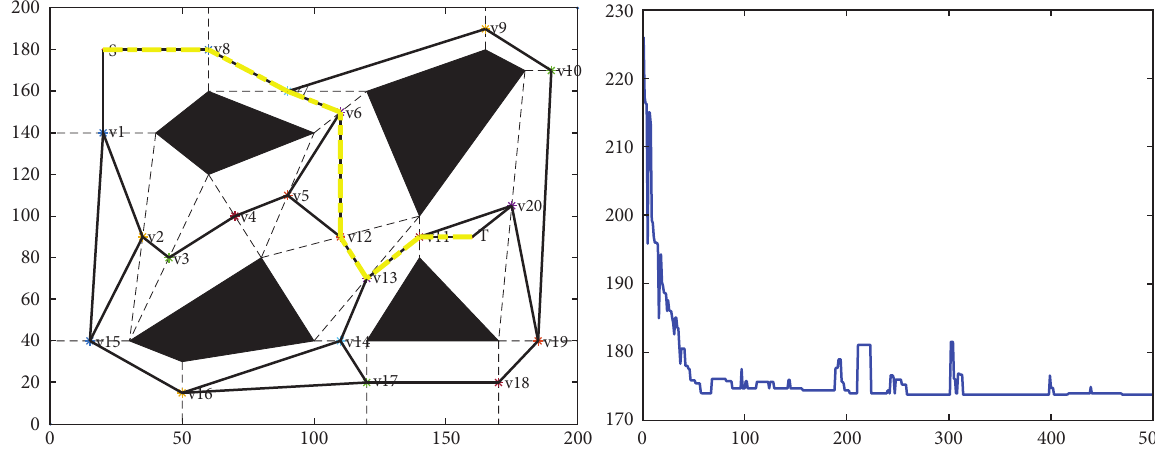
Figure 7: Cloud model visualization